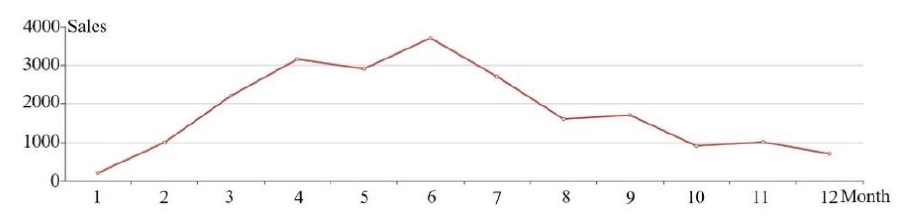
Figure 3. Monthly variation of total pesticide sales.